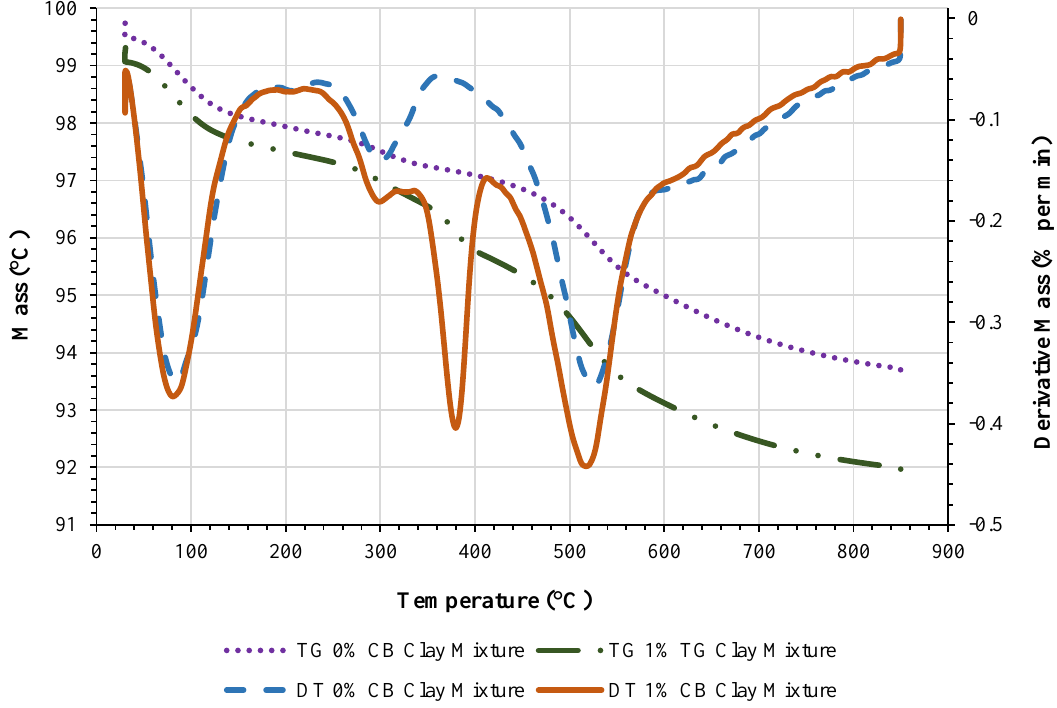
Figure 5. TG and DTA curves of 0% CB content clay mixture and 1% CB content clay mixture.